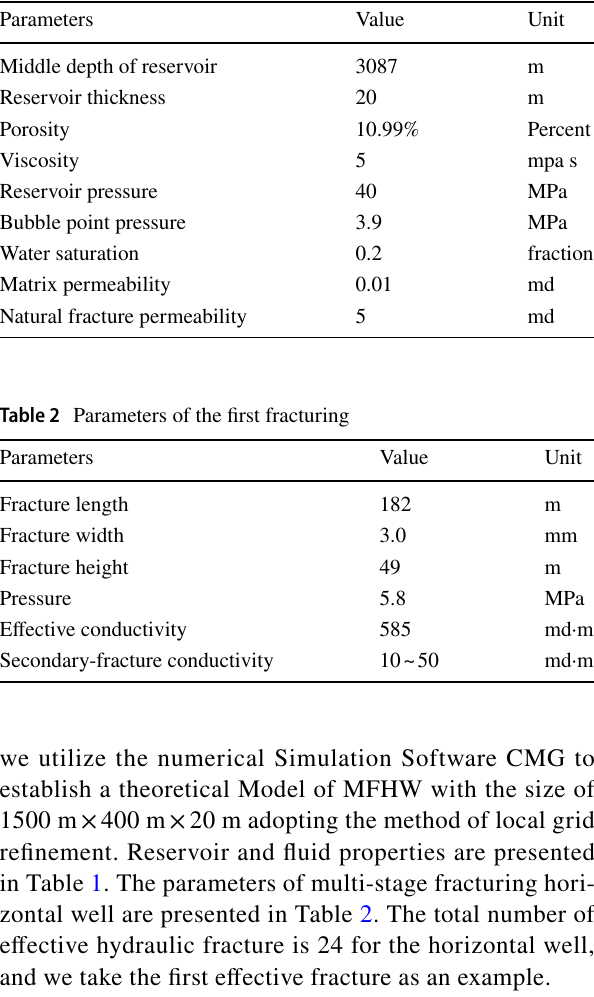
Table 1 Parameters of reservoir and fluid properties